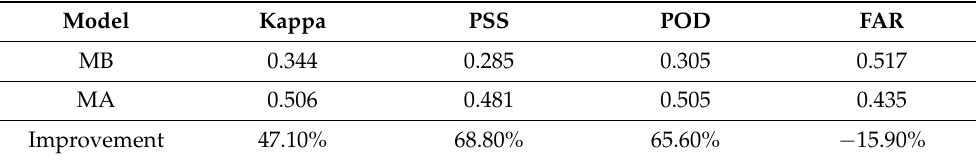
Table 4. Performance comparisons for the tuning benefit. MB and MA denote the models before and after the hyperparameters in GMM-SMOTE and XGBoost are